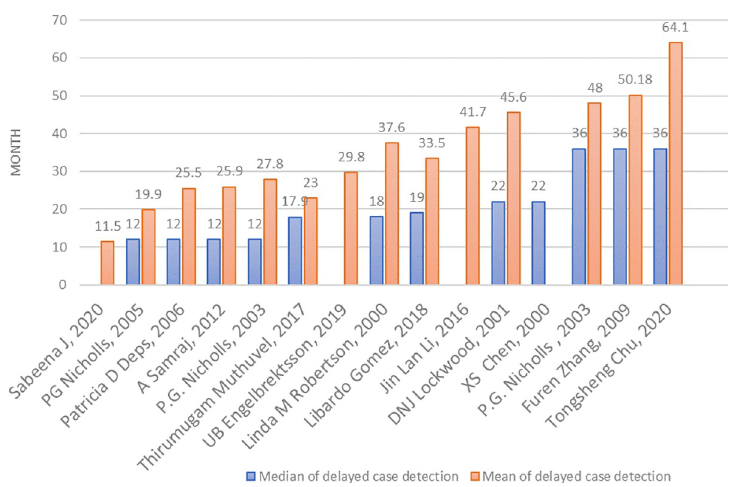
Fig 2. The median and mean time of delayed case detection, in